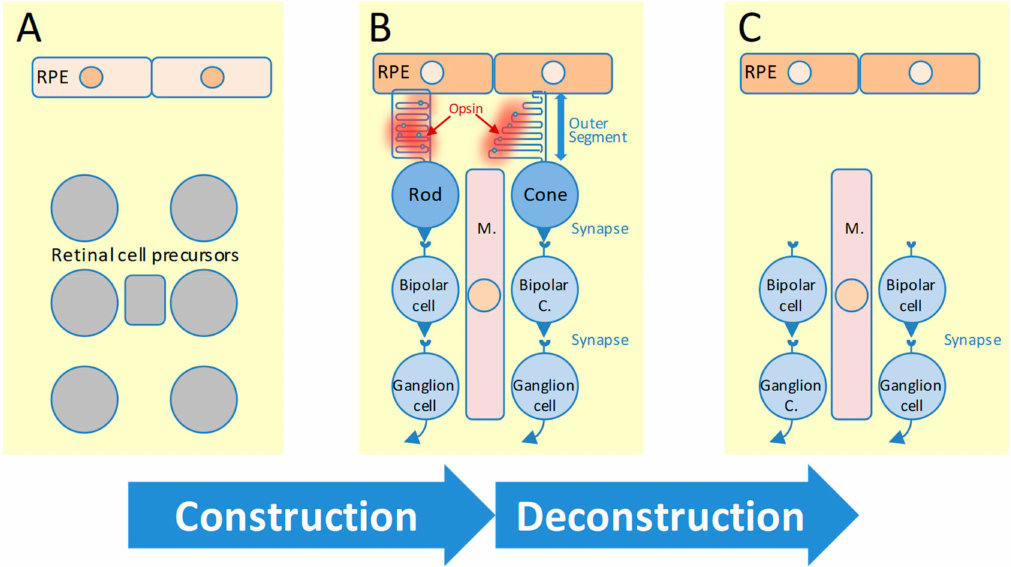
Figure 1. Construction and deconstruction of the retina. ( A ) The di ff erentiation of retinal cell precursors into mature retinal cells relies on a complex gene network. ( B ) The function of the retina requires the transmission of information from photons captured by the outer segment of photoreceptors (rods and cones) to ganglion cells through, a process mediated by synaptic transmission via bipolar cells. The outer segment is renewed after its elimination by phagocytosis by the retinal pigmented epithelium (RPE). ( C ) Inherited retinal degenerations triggers the loss of rods and